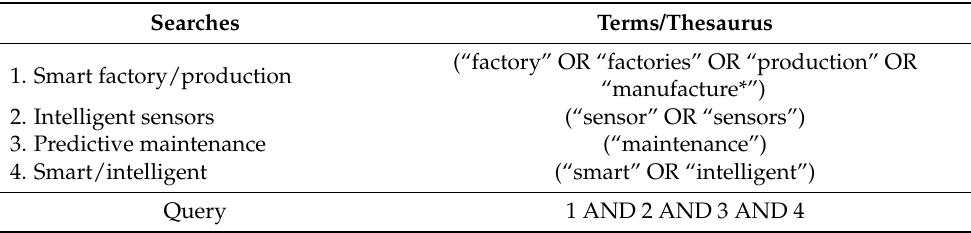
Table 4. Search strategy in the second phase (1 December 2020). Searches Terms/Thesaurus